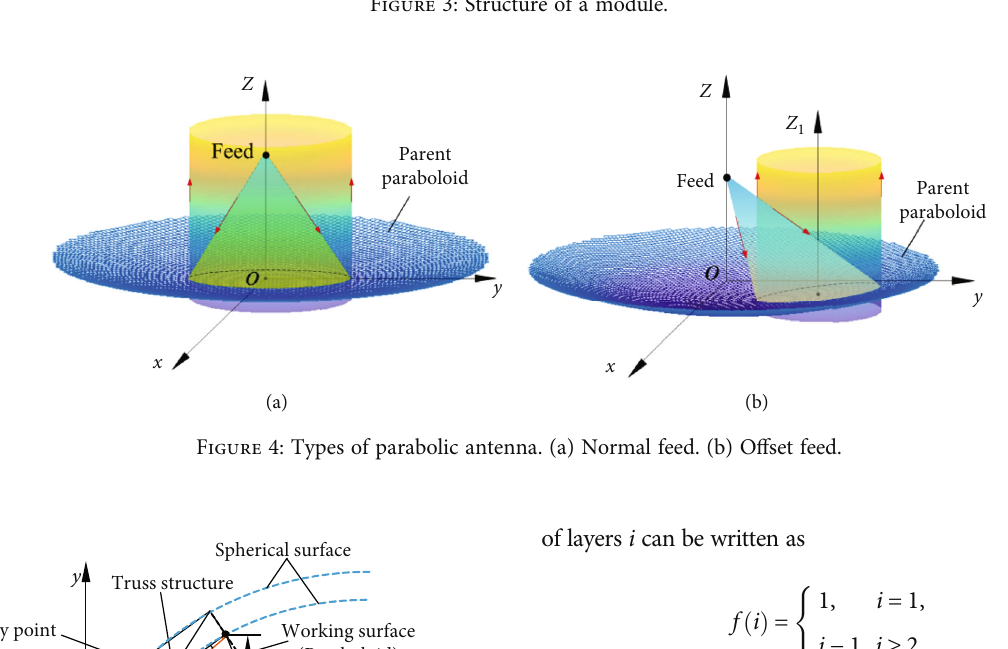
Figure 3: Structure of a module.